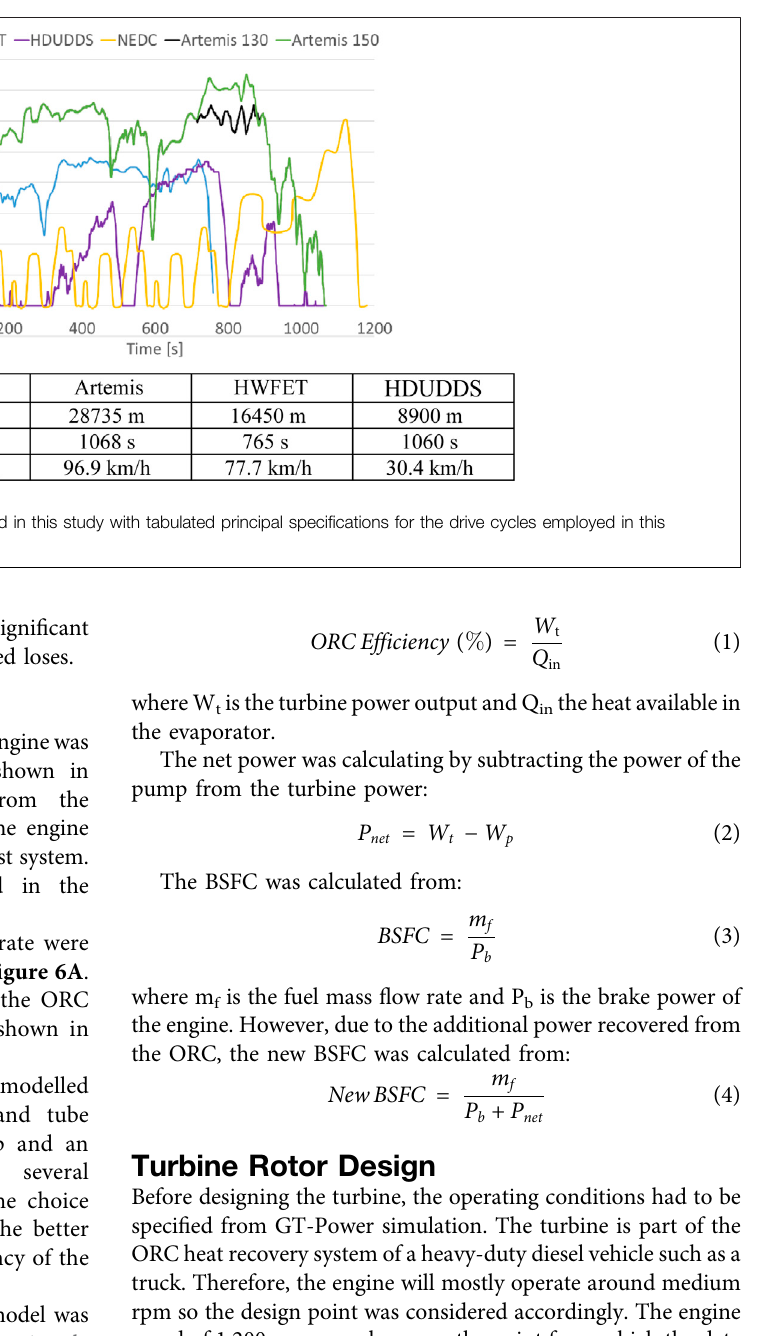
Frontiers in Mechanical Engineering |